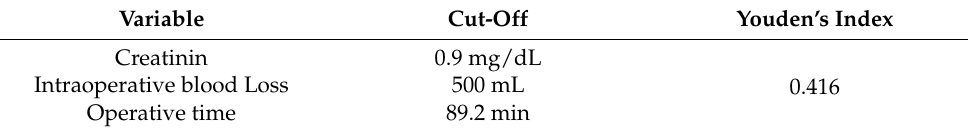
Figure 2. ROC curve of multivariate logistic model. Table 5. Cut-off